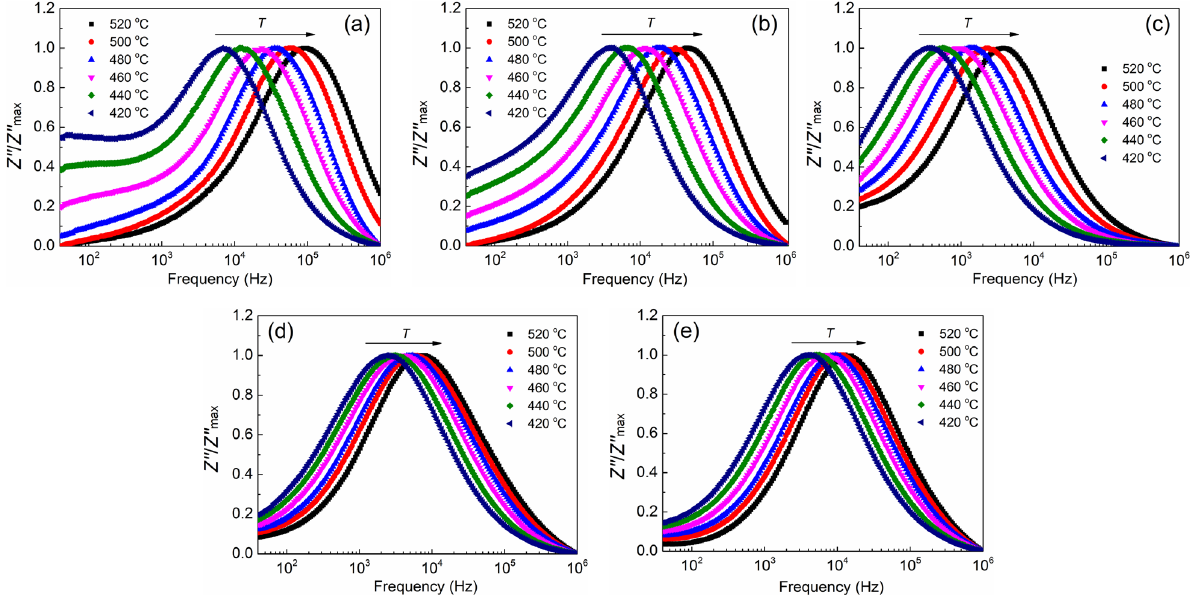
Fig. 8 Normalized imaginary parts of impedance ( Z ″ / Z ″ max ) for (1 − x )KNN– x BZN ceramics as a function of frequency at selected temperatures: (a) x = 0.010, (b) x = 0.015, (c) x = 0.020, (d) x = 0.025, and (e) x =